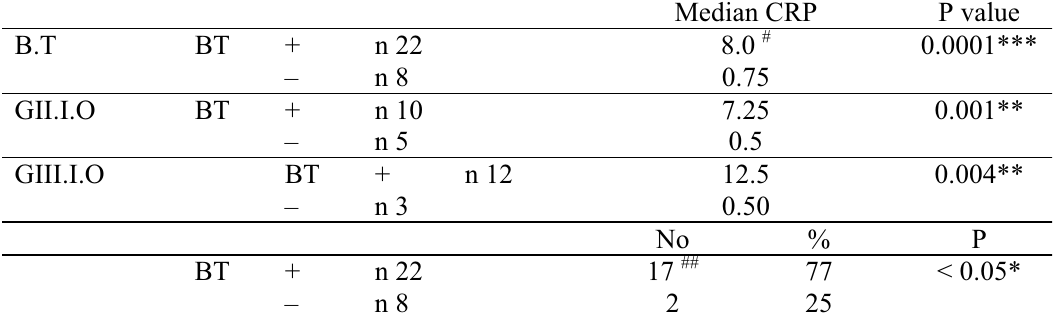
TABLE 6 - CRP relation with bacterial translocation in intestinal obstruction and frequency of positive cases